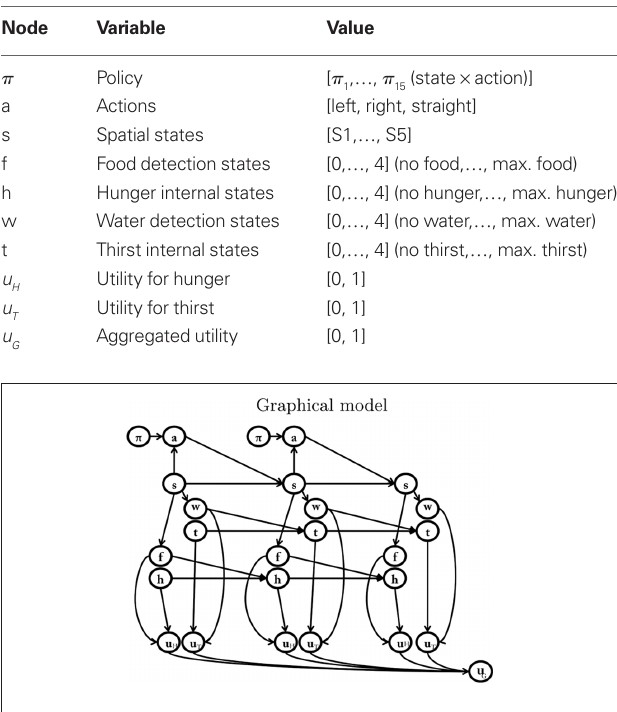
Figure 3 | The model of anticipated motivations adopted in the simulations, which includes two drives, that is, hunger and thirst, and two motivational forward